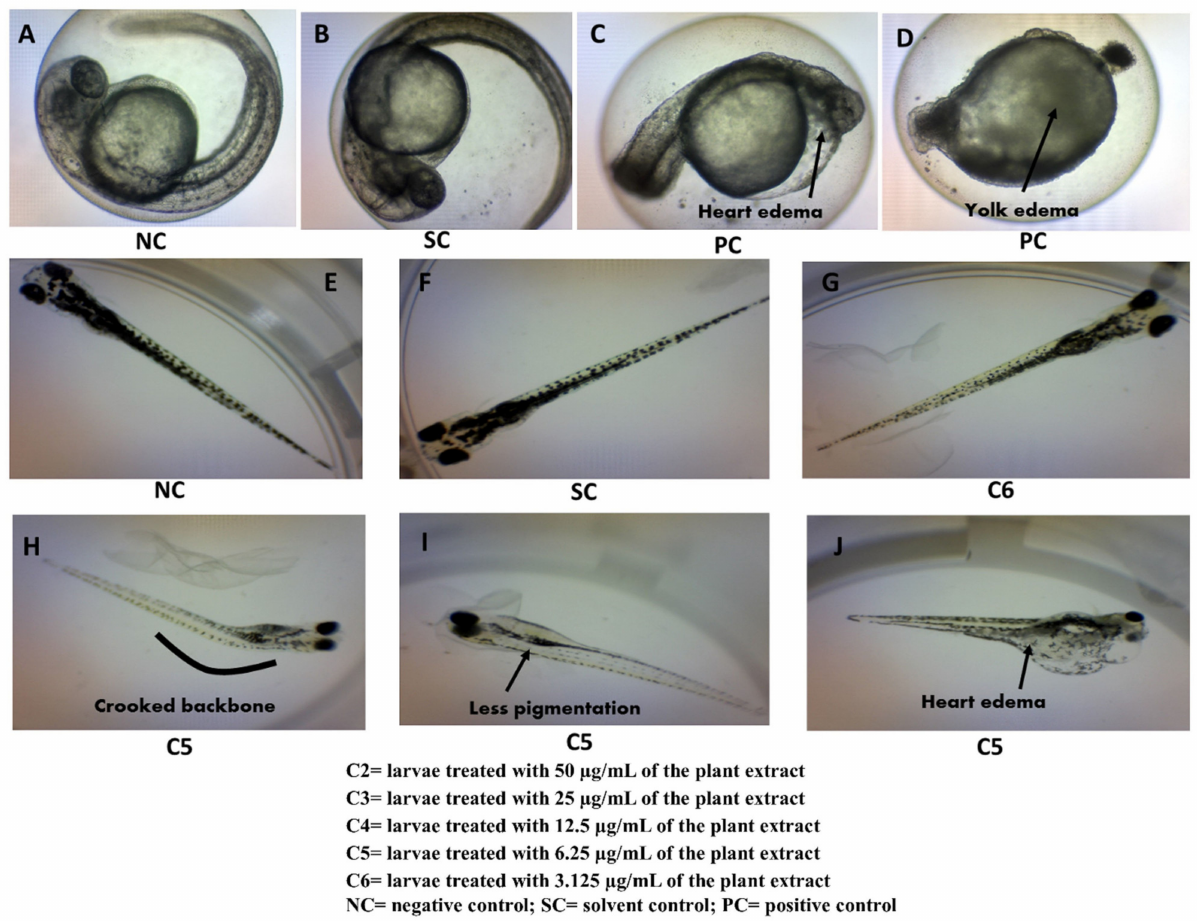
Figure 4. Morphological defect in zebrafish embryo/larvae. ( A ) NC/healthy embryo at 24 hpf; ( B ) embryo in SC at 24 hpf; ( C ) heart edema observed in the PC embryo; ( D ) yolk edema observed in the PC embryo; ( E ) NC/healthy larvae; ( F ) larvae in the solvent control; ( G ) larvae treated with C6; ( H ) crooked backbone observed in the larvae treated with C5; ( I ) less pigmentation observed in the larvae treated with C5; ( J ) heart edema observed in the larvae treated with